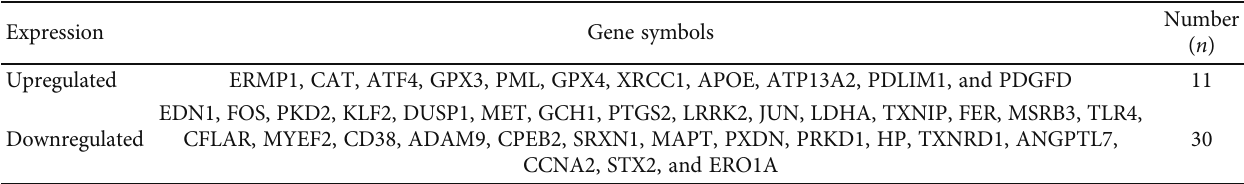
Table 1: Detailed information of 41